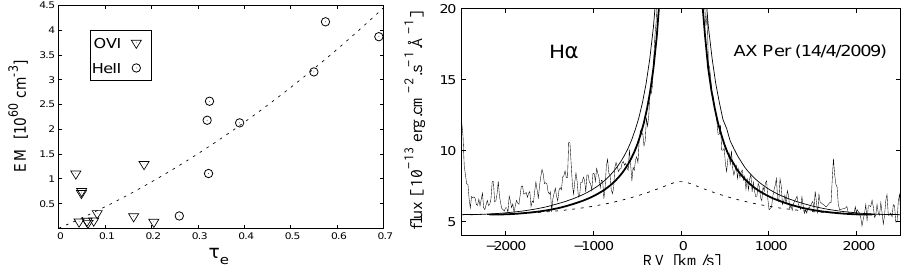
Fig. 2. Left panel . Empirical relationship EM ( (cid:28) e ) derived for different levels of ac- tivity of symbiotic stars Z And, AG Dra and V1016 Cyg. Right panel . The profile of H (cid:11) wings of the symbiotic star AX Per during its active phase (adopted from Skopal et al. 2011). The thin line is the model corresponding to the observed profile, while the thick line fits the wings after subtraction the electron scattering contribution (dotted